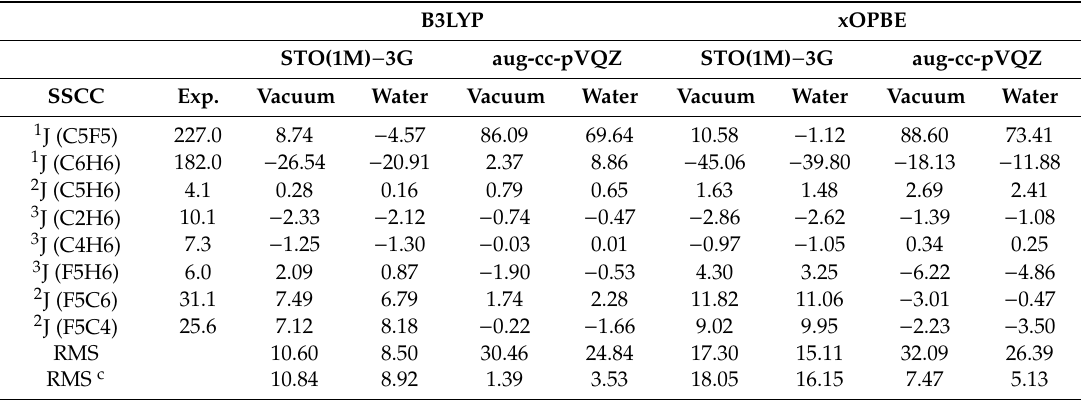
Table 6. Deviation of B3LYP and xOPBE with STO(1M) − 3G and aug-cc-pVQZ(mixed) basis sets calculated indirect spin-spin coupling constants (in Hz) for 5-fluorouracil in the gas phase and in water a with experimental values in DMSO b